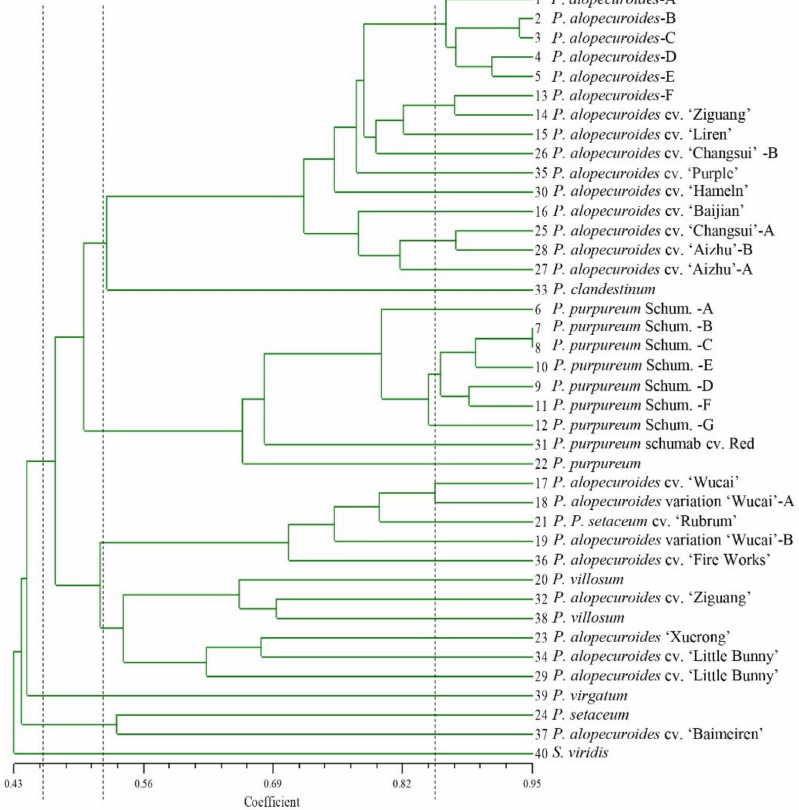
Figure 2. UPGMA clustering analysis of 40 samples. The number on the horizontal axis in the figure represents the genetic coefficient, and the number on the vertical axis represents the samples number from 1 to